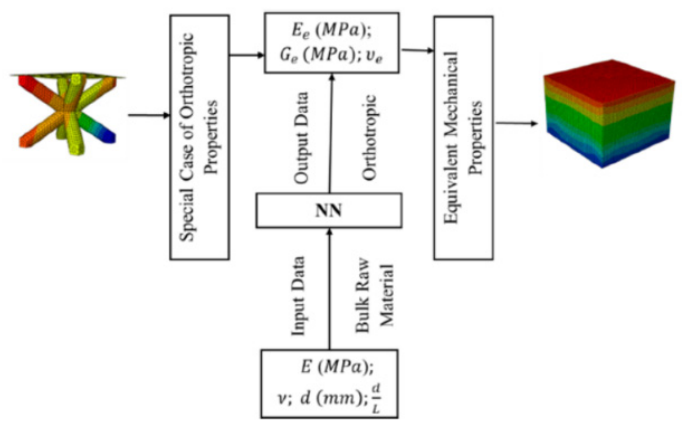
Figure 6. Integration of FEA model to NN model Figure 6 . Integration of FEA model to NN model [32] . Table 1. Summary of (HM) Homogenization Methods.